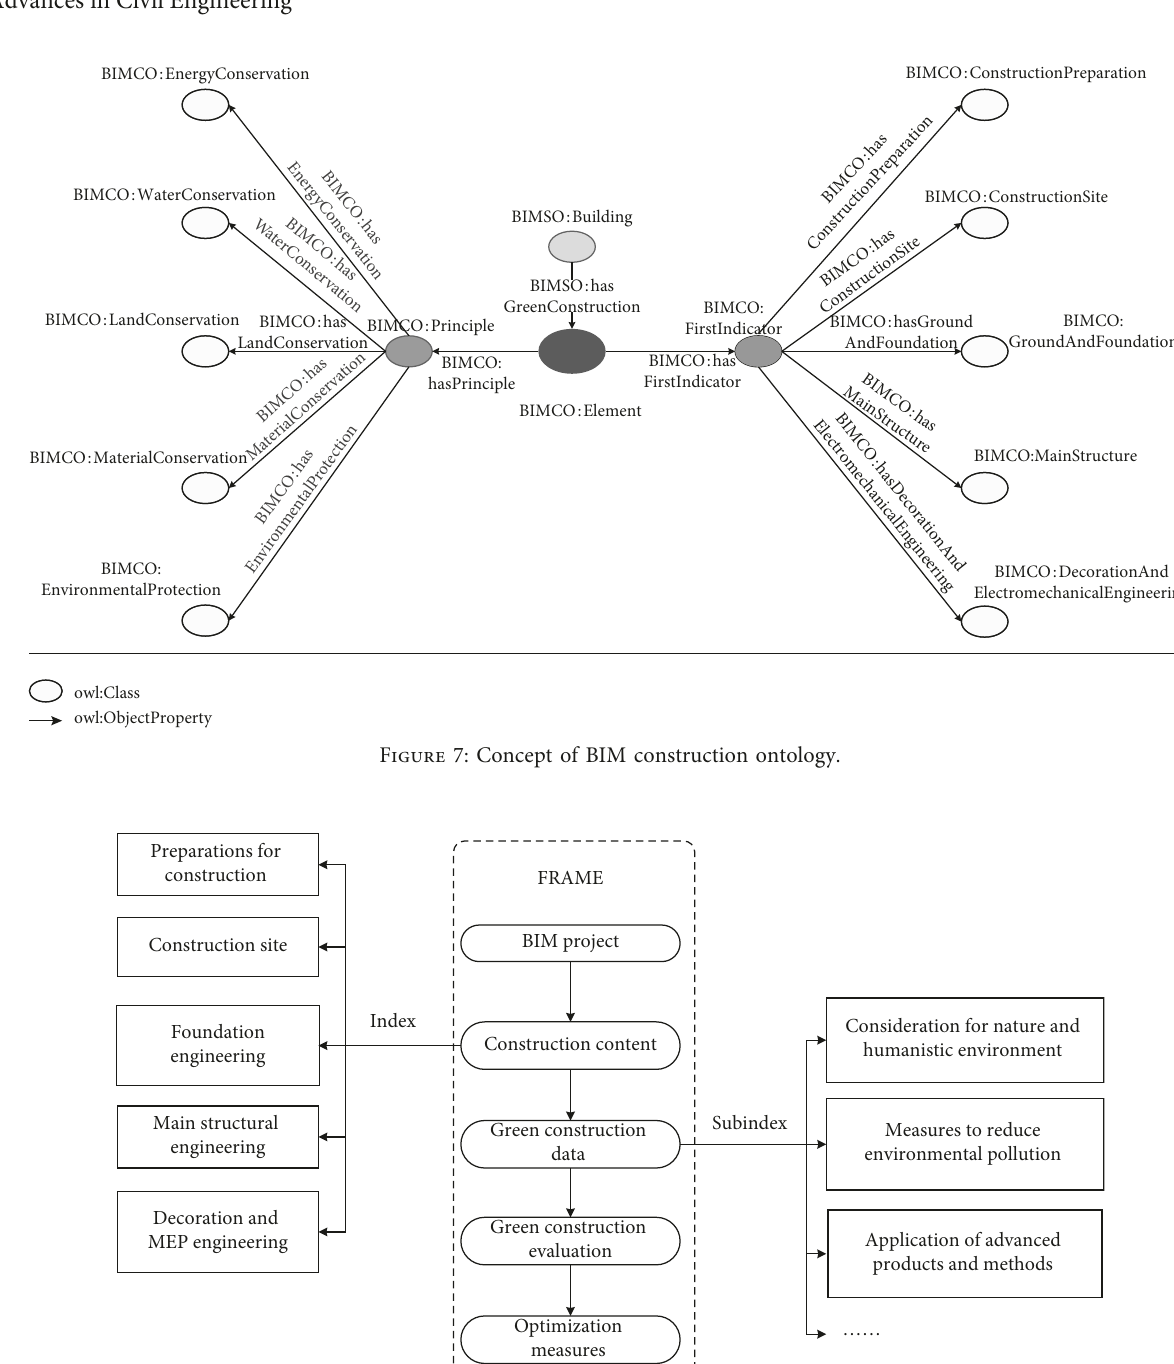
Figure 8: Framework of BIM knowledge base.